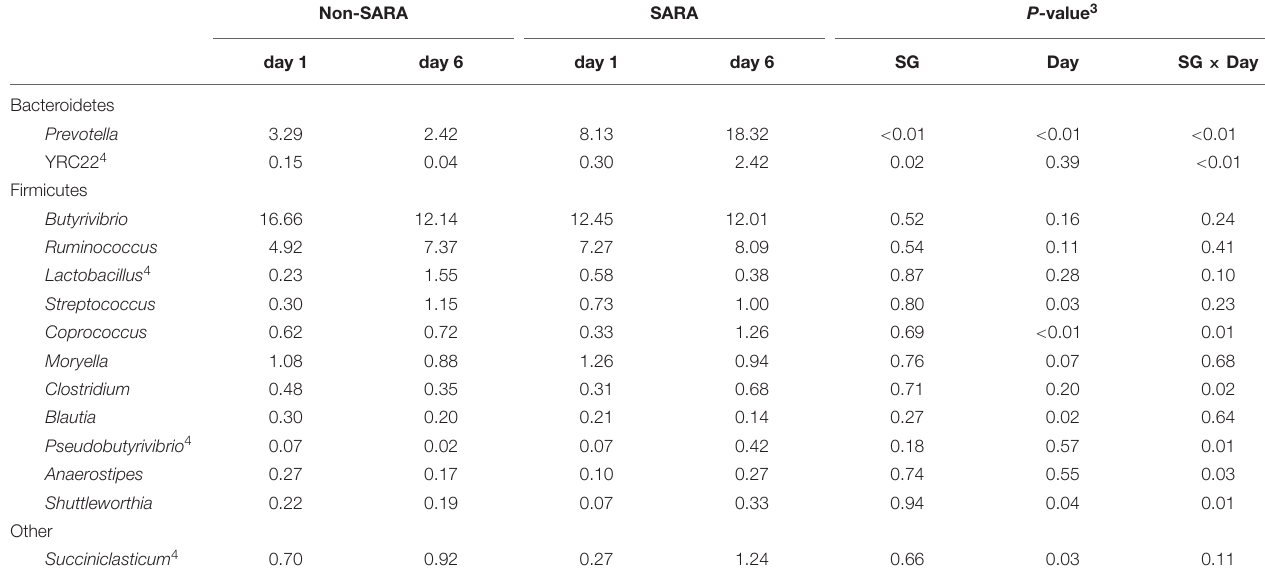
Non-SARA SARA P -value